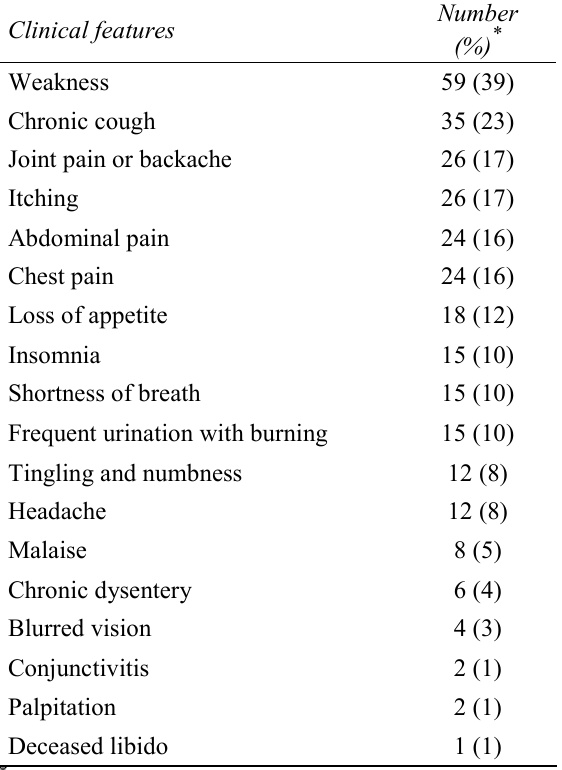
Table 2: Ranking of clinical symptoms of arsenic- related illnesses in 150 patients admitted to the